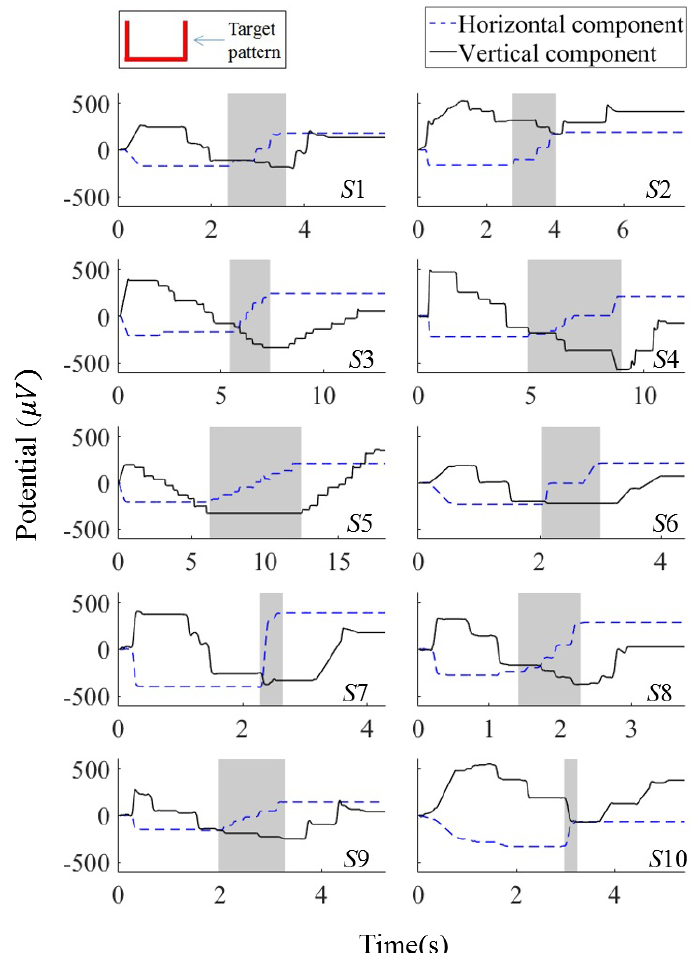
Figure 5. Horizontal and vertical EOG components for all subjects after saccade detection. The subject identification numbers are indicated at the bottom-right of each plot (from S 1 to S 10). The shaded regions indicate the time periods in which the subjects moved their gazes in the horizontal direction.